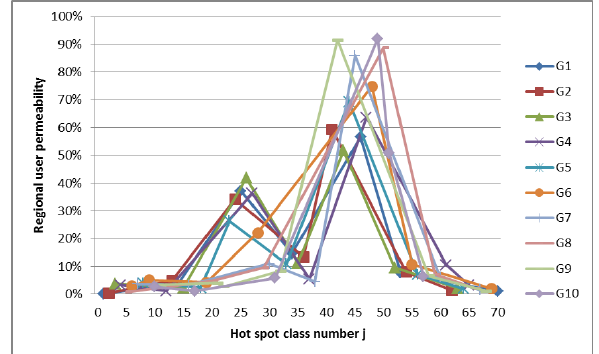
Figure 5. User permeability of hot access areas